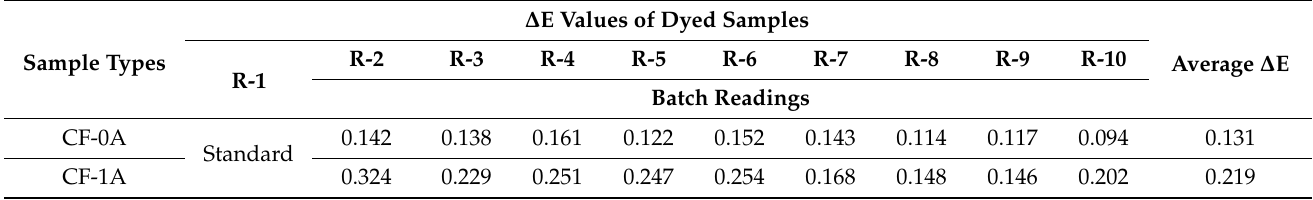
Table 6. Distribution of color (degree of color